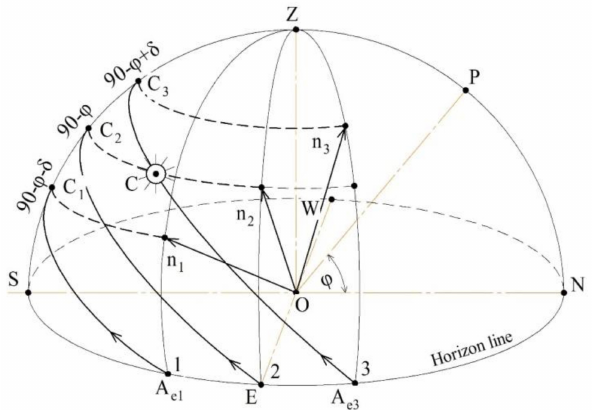
Figure 11. Pathway of the Sun (continuous lines) and end of the normal (dash lines) of the tracking surface of a vertical-axis tracker)—designed based on [21,23,35,36]: 1-in winter; 2-in the period of equinox; 3-in